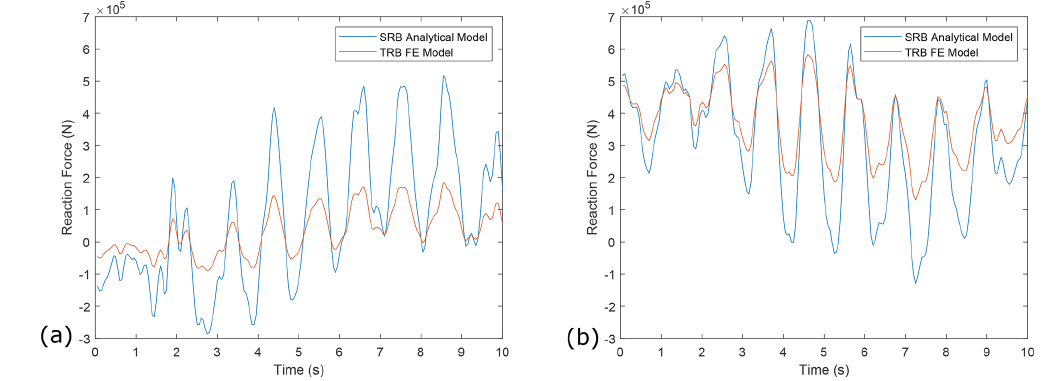
Figure 8. (a) Example time series of reaction force results in the horizontal plane from the analytical and DTRB FE models. (b) Example time series of reaction force results in the vertical plane from analytical and DTRB FE models.